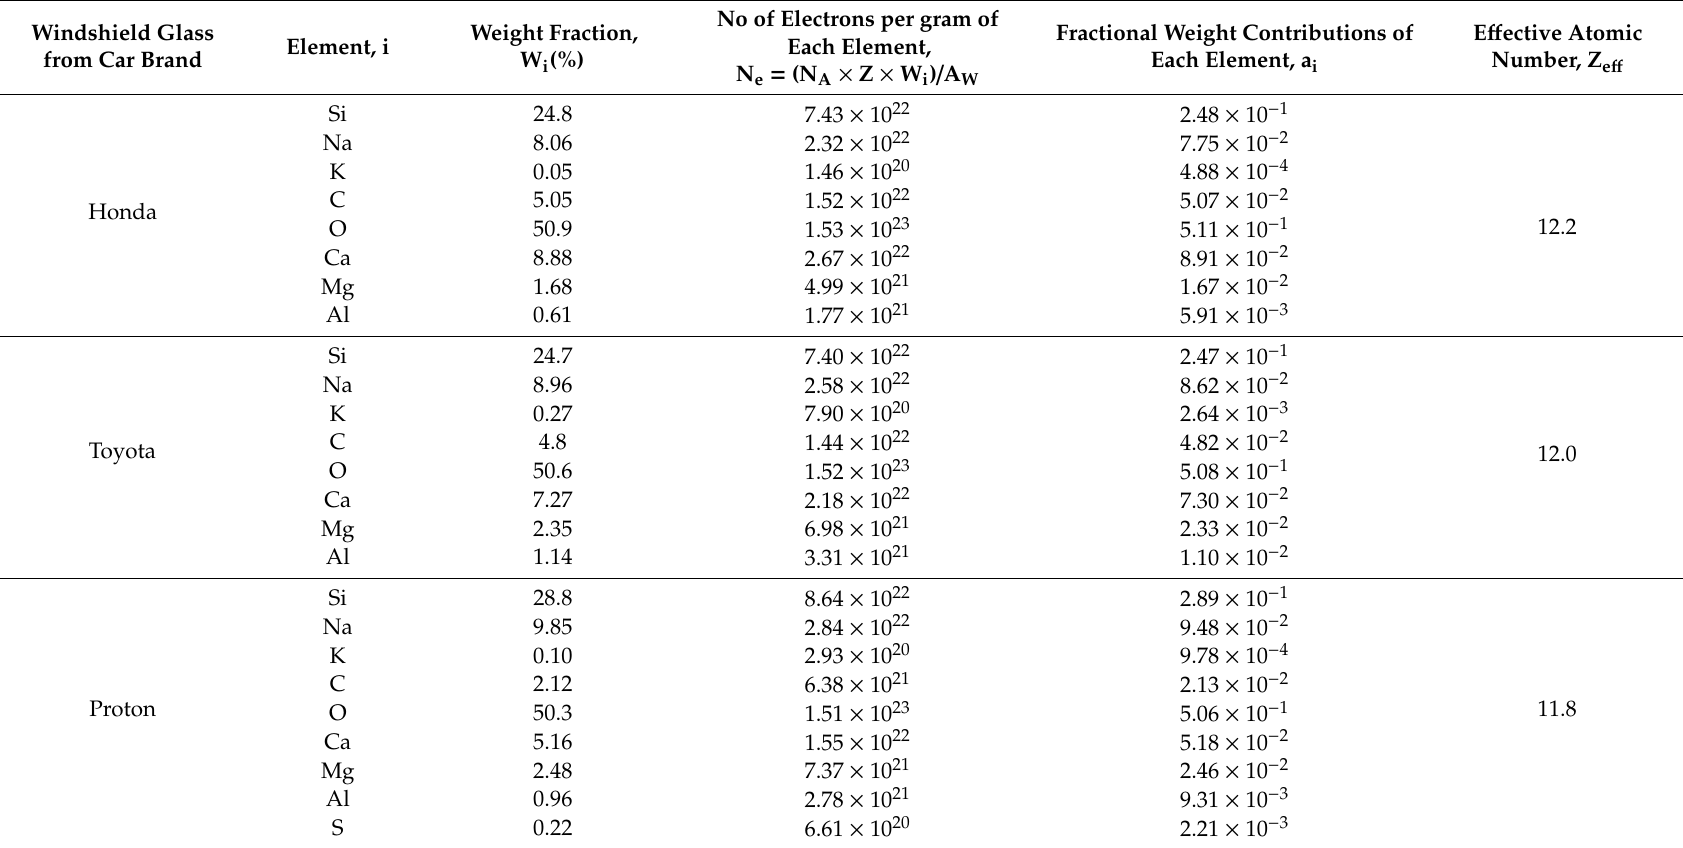
Table 2. Elemental composition of car windshield glass samples from EDX